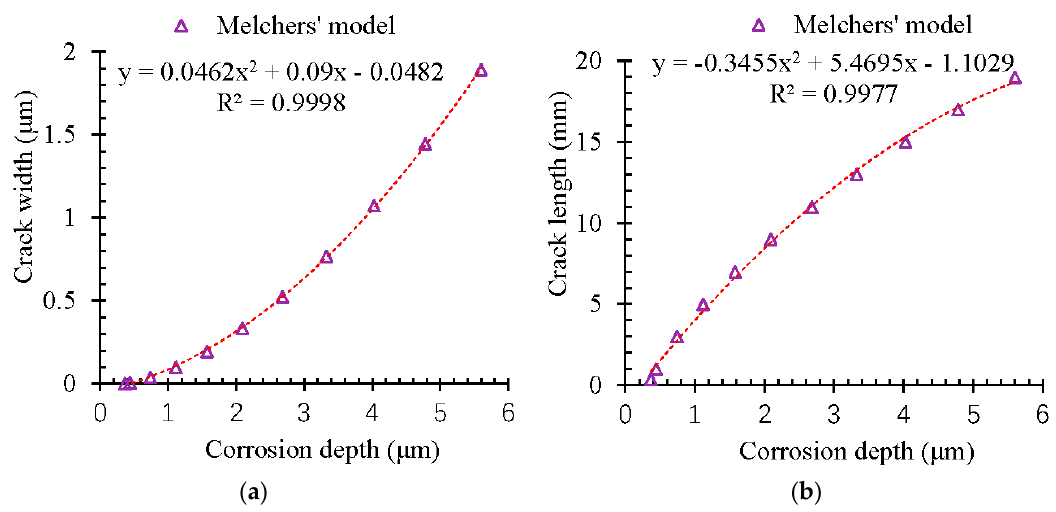
Figure 12. Propagation of the length of the corrosion-induced cracking path. ( a )Propagation of the cracking width. ( b ) Propagation of the cracking length.